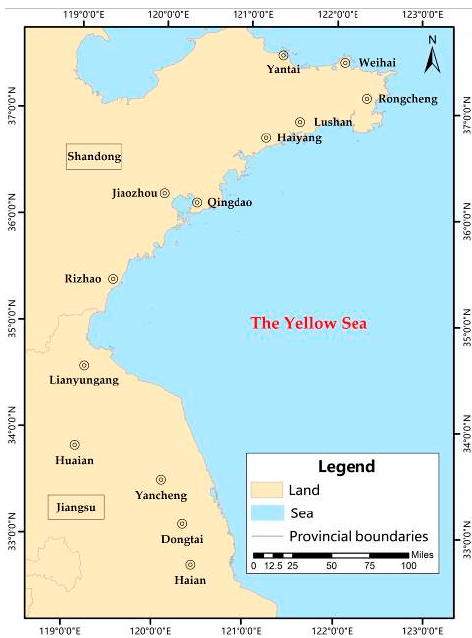
Figure 1. Map of the study area and major cities along the coast.